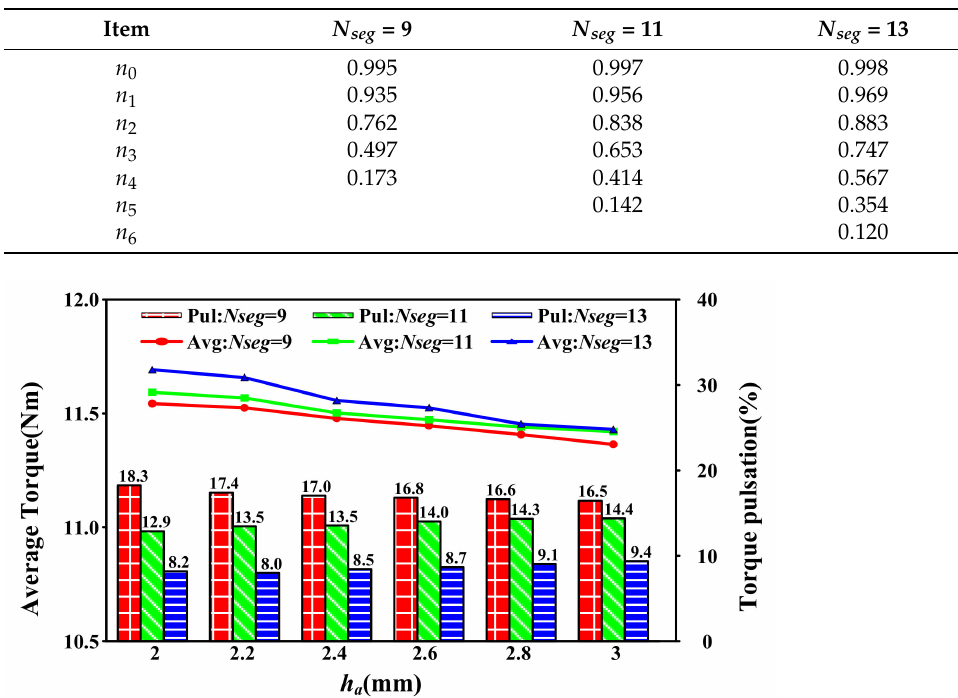
Table 2. The value of n i for different segments of stairs.